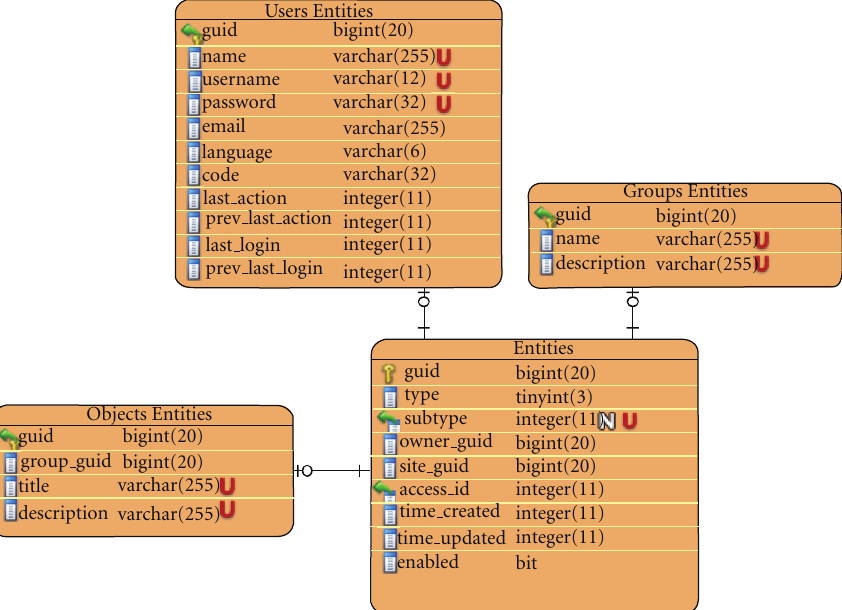
Figure 9: The tables “Users Entities,” “Groups Entities,” and “Object Entities” as well as their relationship with the “Entities.”